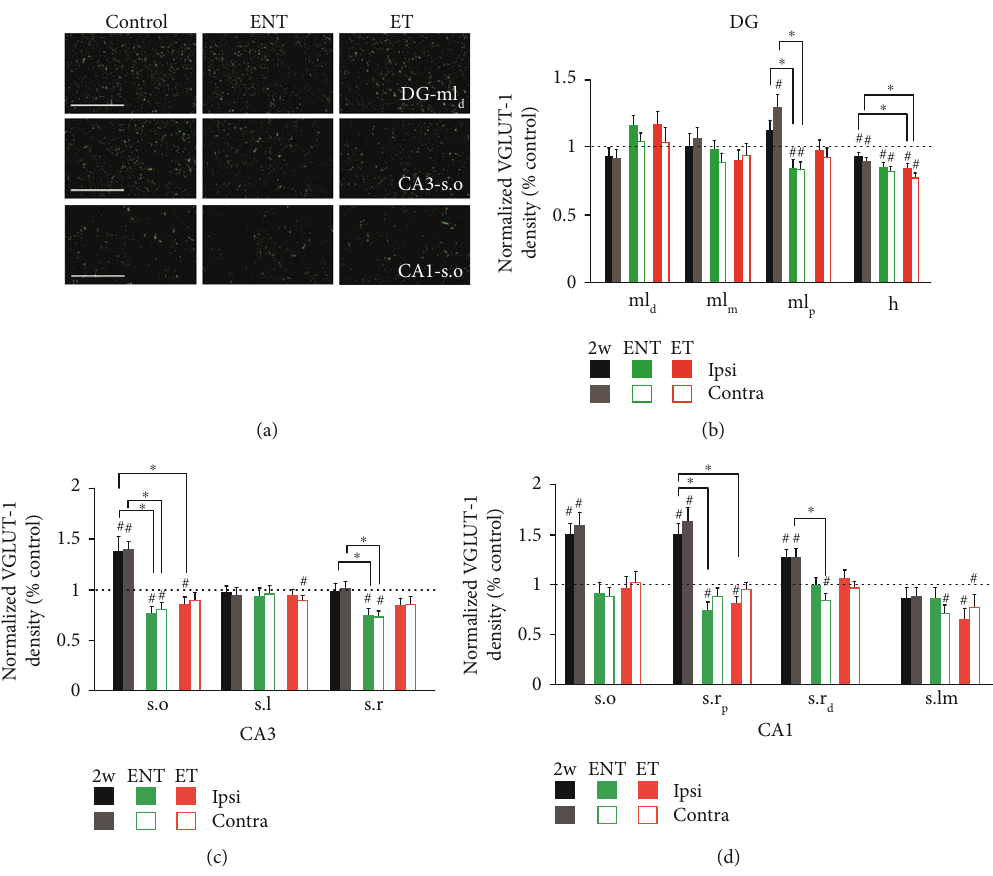
Figure 6: Tinnitus and no-tinnitus animals exhibit recovery of VGLUT-1 labeling by 12-week postnoise exposure in the dentate gyrus (DG), area CA3 and CA1. (a) Representative images of VGLUT-1 labeling from distal molecular layer of the DG (DG-ml ), stratum oriens of CA3 d (CA3-s.o), and stratum oriens of CA1 (CA1-s.o) at 400x magni fi cation; scale bar = 50 μ m . (b – d) Mean ( ± SEM) change of VGLUT-1 density (normalized to respective control) on both ipsilateral (left) and contralateral (right) sides in the DG (b), CA3 (c), and CA1 (d) in two-week and 12-week postnoise-exposure animals. Both sides are pooled for comparison between groups (2w, ENT, and ET). Compared to two-week postexposure animals (2w), 12-week postexposure animals (ENT and ET) largely recovered to or near to baseline levels. Animal exhibiting tinnitus (ET) showed similar pattern of recovery in VGLUT-1 expression to animals resistant to tinnitus in all the three subregions. # For : distal region comparison to the paired controls (dashed line), p ≤ 0 : 05 . ∗ For comparison between 2w, ENT, and ET groups, p ≤ 0 : 05 . ml d of molecular layer; ml : middle region of molecular layer; ml : proximal region of molecular layer; h: hilus; s.o: stratum oriens; s.l: stratum m p lucidum; s.r: stratum radiatum; s.r : proximal region of stratum radiatum; s.r : distal region of stratum radiatum; s.lm: stratum p d